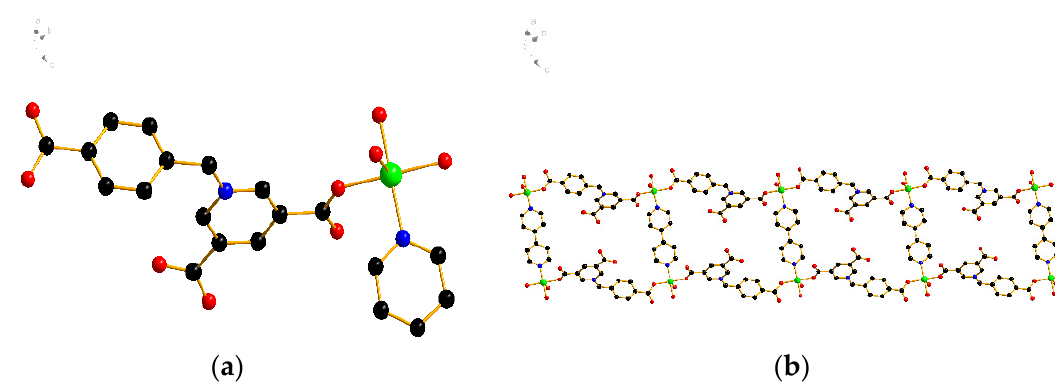
Figure 1. Crystal structure of the prepared MOF. ( a ) The asymmetric element of MOF. ( b ) The one-dimensional grid plane structure of MOF. Atomic colors: Cu (green), N (blue), O (red), and C (black). Table 2. Main bond lengths (Å) and angles ( ◦ ) for